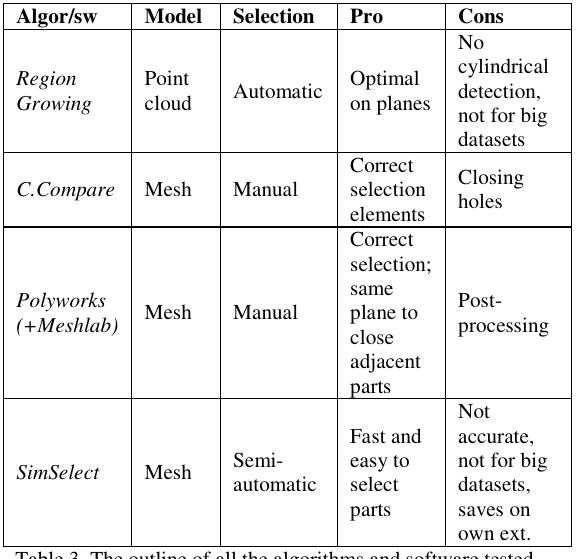
Table 3. The outline of all the algorithms and software b Figure 15. The differences in automatic selection with SimSelect: with expansion 1 (a) and with expansion 6 (b). The columns highlighted in dark red are the ones selected manually to give the shape for the automatic selection.